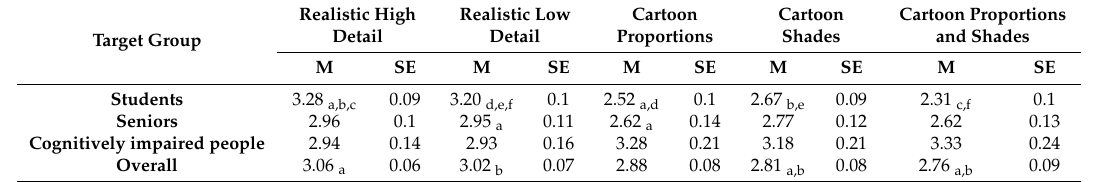
Table 2. Likability ratings for agents’ degrees of realism of all target